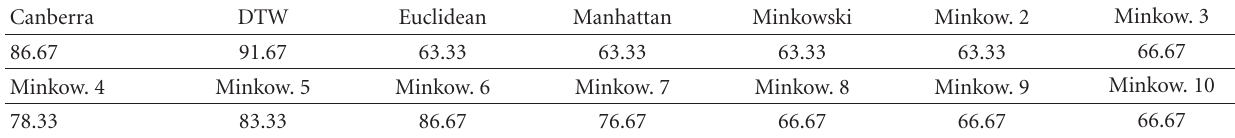
Algorithm 1: Pseudo code of dynamic time wrap algorithm. Table 2: Percentage of correctly clustered groups in various similarity